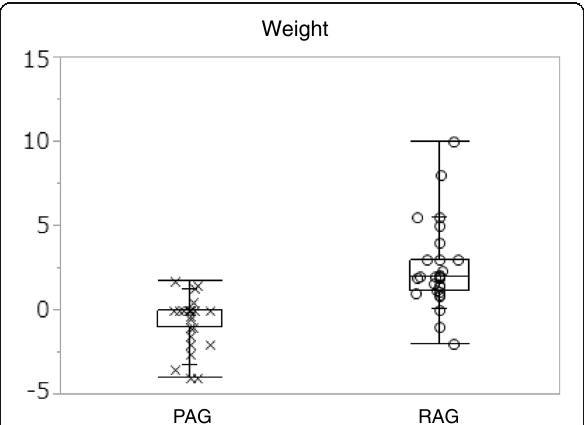
Fig. 2 Difference of BODE index between baseline and after 12 weeks for each group is shown. The difference in the BODE index in the RAG ( − 1.2 [1.2]) was statistically significant compared with that in the PAG ( − 0.03 [1.0]) (mean difference − 1.17, 95% CI -1.55 to − 0.55 by